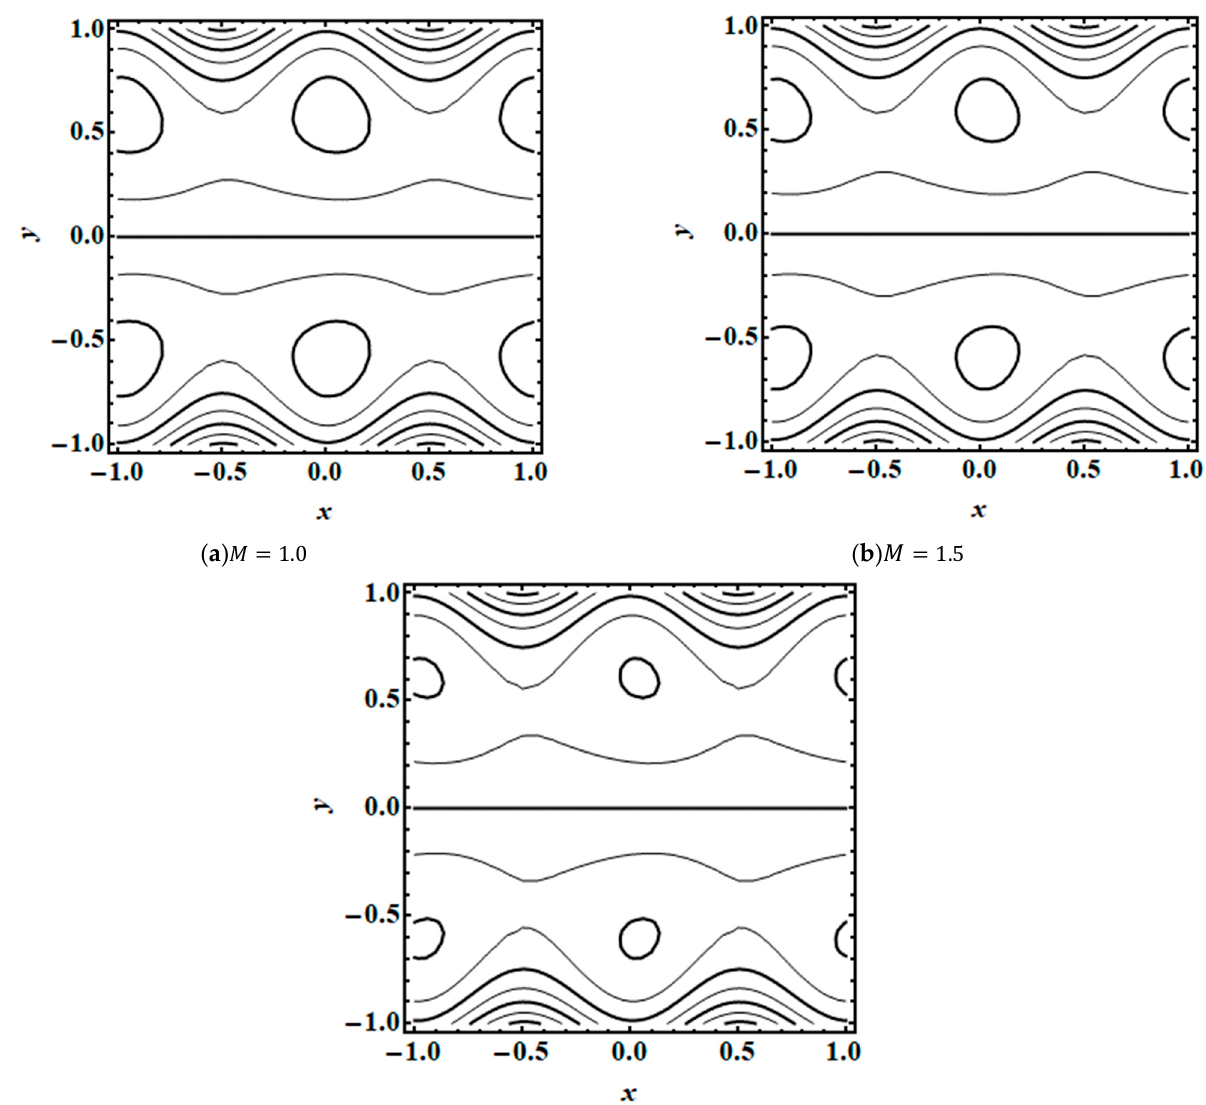
Figure 6. Influence of the Hartmann number M on the streamline patterns for α = 0.4, β = 0.4, ε = 0.1, Q = 1.5, λ 1 = 1, 𝐾 = 0.1, 𝑅𝑒 = 0.1.